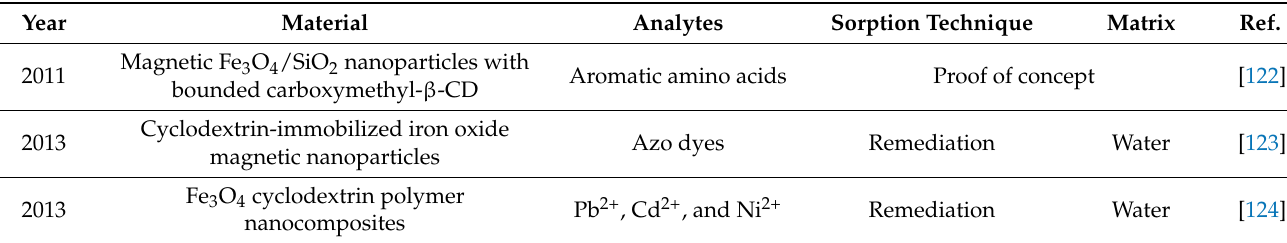
Figure 9. Schematic representation of the experimental procedure to prepare β -CD–graphene nanohybrid and its interactions with an aflatoxin molecule. Reproduced from [142], with permission from Copyright 2020 Elsevier. Table 3. An overview of the reported studies on the use of nanomaterials and metallic nanoparticles with cyclodextrin for the adsorption of environmentally concerning compounds.